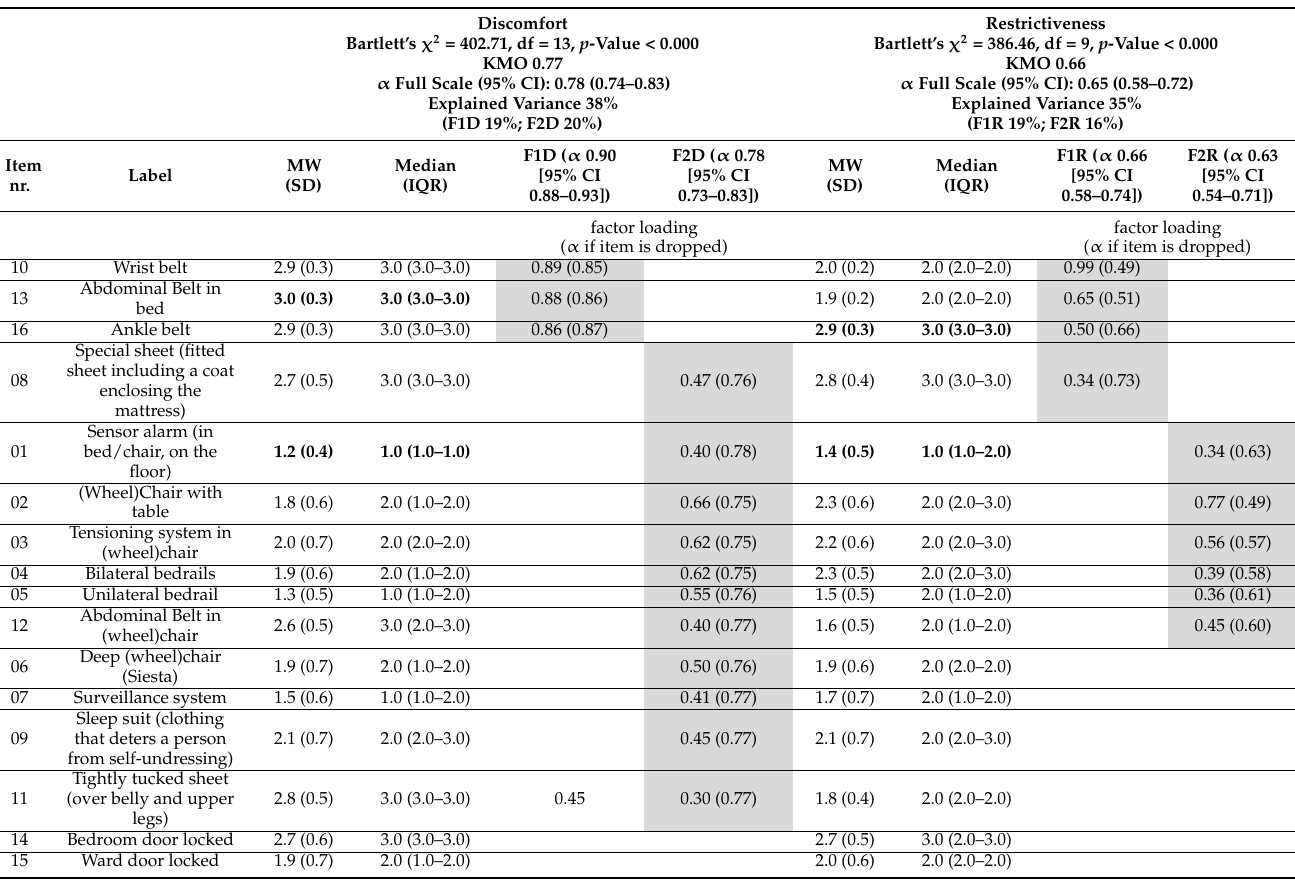
Table 4. Descriptive and factor analysis for the Discomfort and Restrictiveness